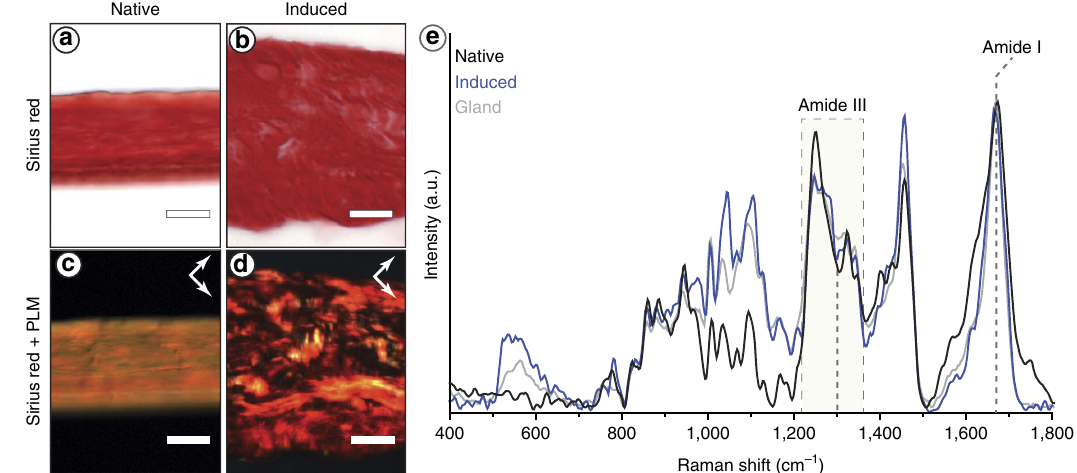
Figure 5 | Histological and Raman characterization of induced thread core. ( a , b ) Sirius red-stained longitudinal cryo-section of a ( a ) native thread and ( b ) induced thread. ( c , d ) PLM images of the same region in ( a ) and ( b ) showing differences in birefringence and thus, protein alignment. Arrows show the orientation of the crossed polarizers. ( e ) Raman spectra from the core gland vesicles, induced core and native core, highlighting the differences in native thread spectra. Scale bar is 20 m m for panels a – d